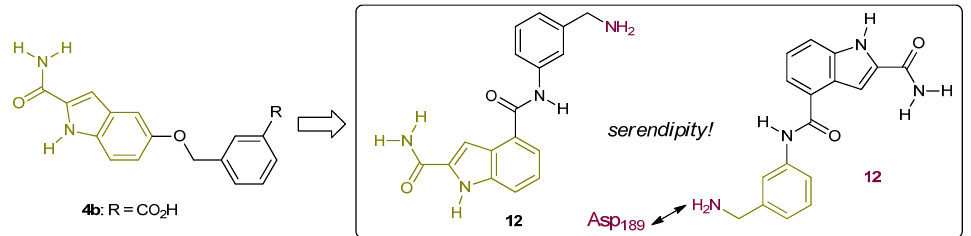
Figure 8. Serendipitous discovery of FD ligand 12 binding to the enzyme unlocked conformation (S1 open conformation).